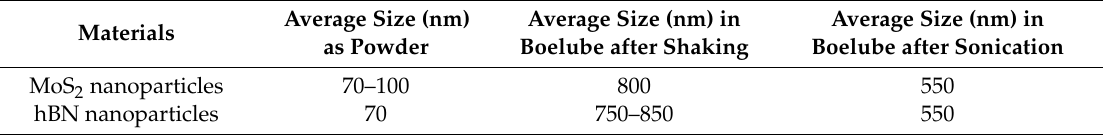
Table 1. Nanoparticles and their dispersion characteristics.